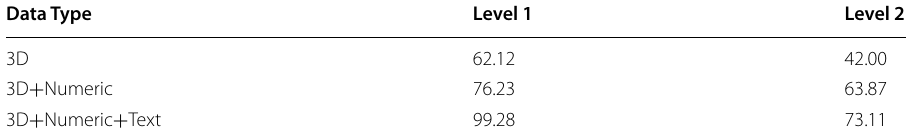
Table 3 Prediction accuracy (%) in different classification levels and data types